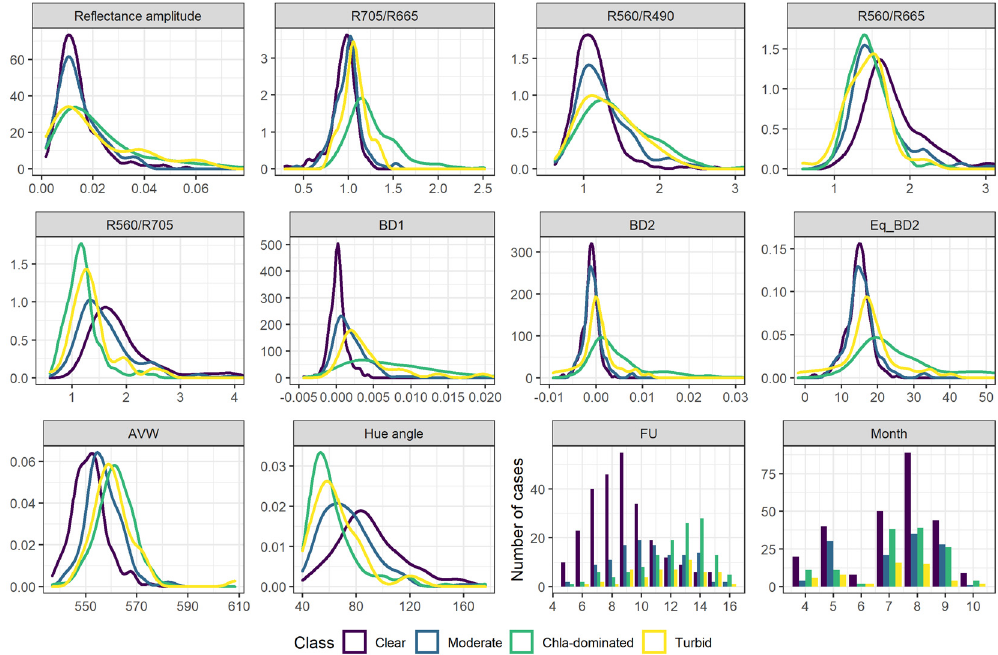
Figure 2. The distribution of 12 features by biophysical class (Clear, Moderate, Chla-dominated, Turbid). The features found in the first and the second row are dimensionless, except Eq_BD2—that is the concentration of chlorophyll α in mg/m 3 . The unit of Apparent Visible Wavelength (AVW) nm, the unit of hue angle—degrees, FU—the class as from Forel-Ule colour scale, and the last one is the number of months of an observation.